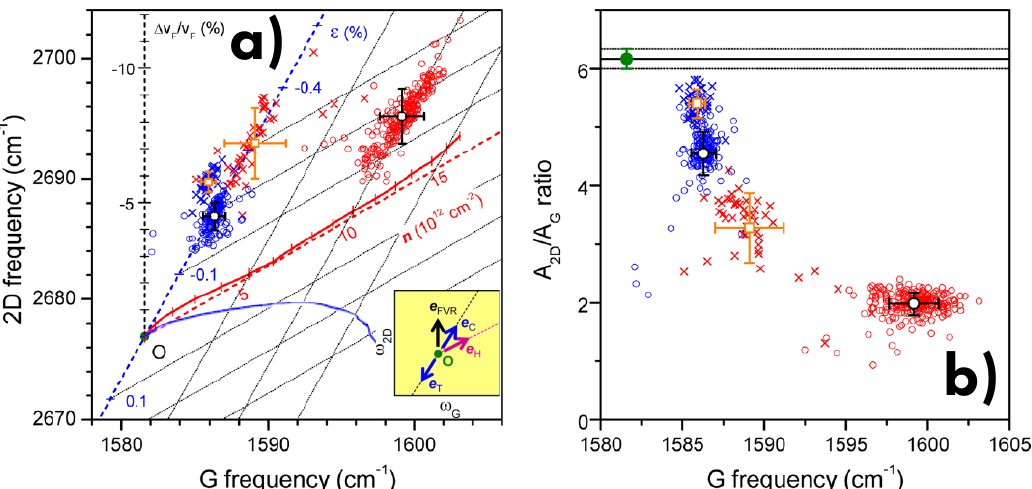
Figure 27. ( a ) G-2D map of graphene in various doping and strain configurations. Each point corresponds to a given G and 2D peak position extracted from a given spectrum. The map is described by three independent axes: doping (n) by distinguishing between p (red) or n (blue) doping, strain ( ε ), and Fermi velocity variation ( Δ v F /v F , black) ( b ) doping influence on I 2D /I G . Adapted with permission from Ref. [109]. Copyright (2013) American Chemical